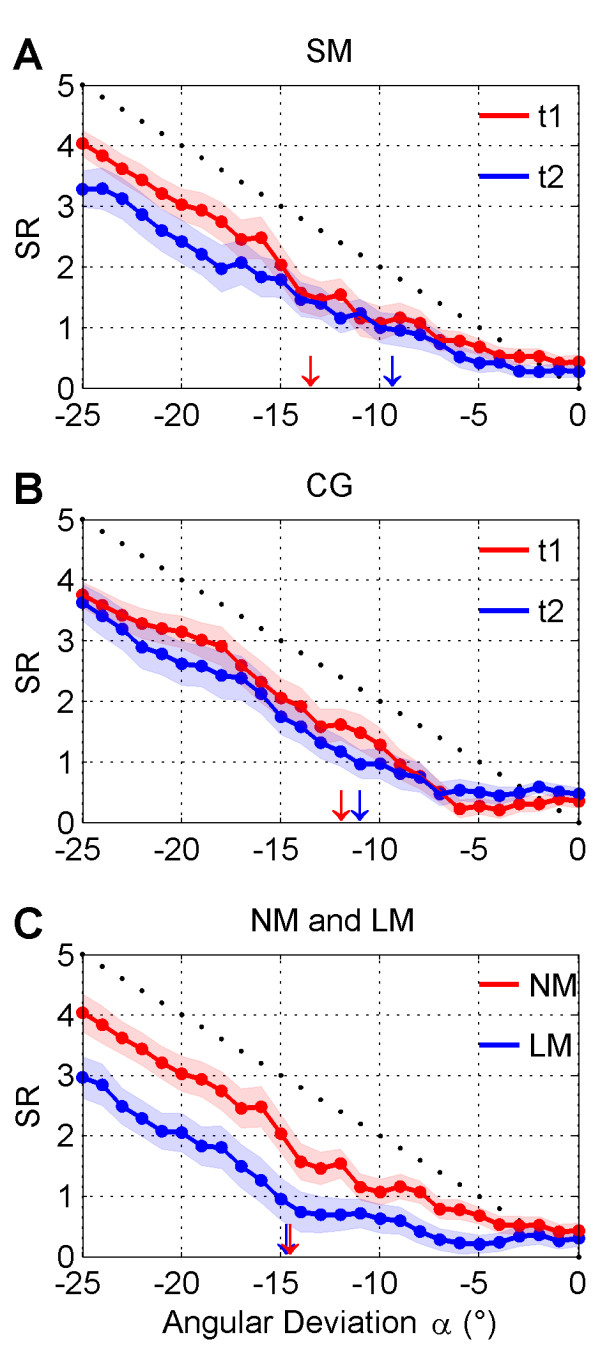
Mean and Standard Error of Subjective Report (SR). A) Comparison between SR values before (t1) and after (t2) the MBSR intervention for the SM group. B) Comparison of SR values at times t1 and t2 for the CG group. C) Comparison of SR values between the NM (red) and LM (blue) groups. Shading indicates standard error (SE). SR data for t1 and t2 measurement points and groups LM and NM are denoted by blue and red colors respectively. Downward arrows indicate the adjusted mean of angular threshold in each group and measurement point (same color coding).